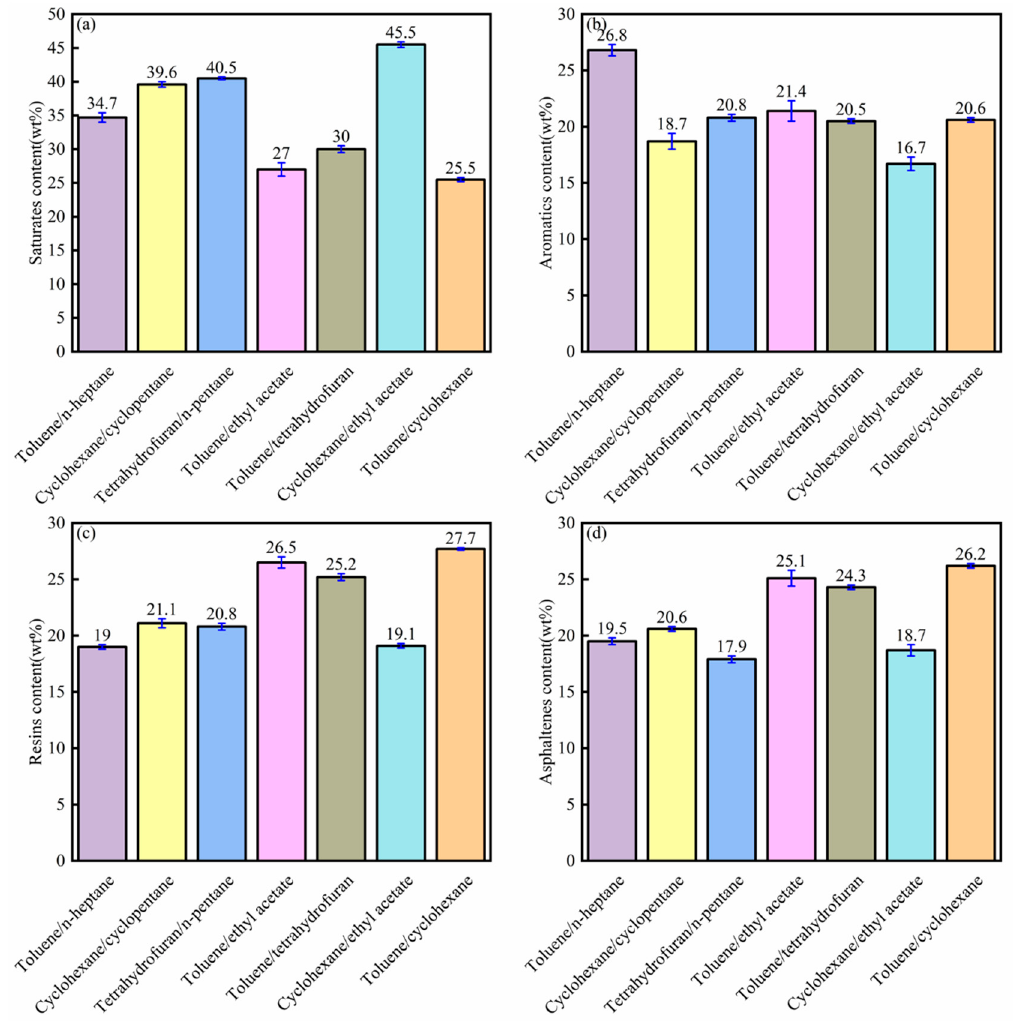
Figure 8. Saturate ( a ), aromatic ( b ), resin, and ( c ) asphaltene ( d ) contents of the bitumen from different composite solvent extraction experiments.